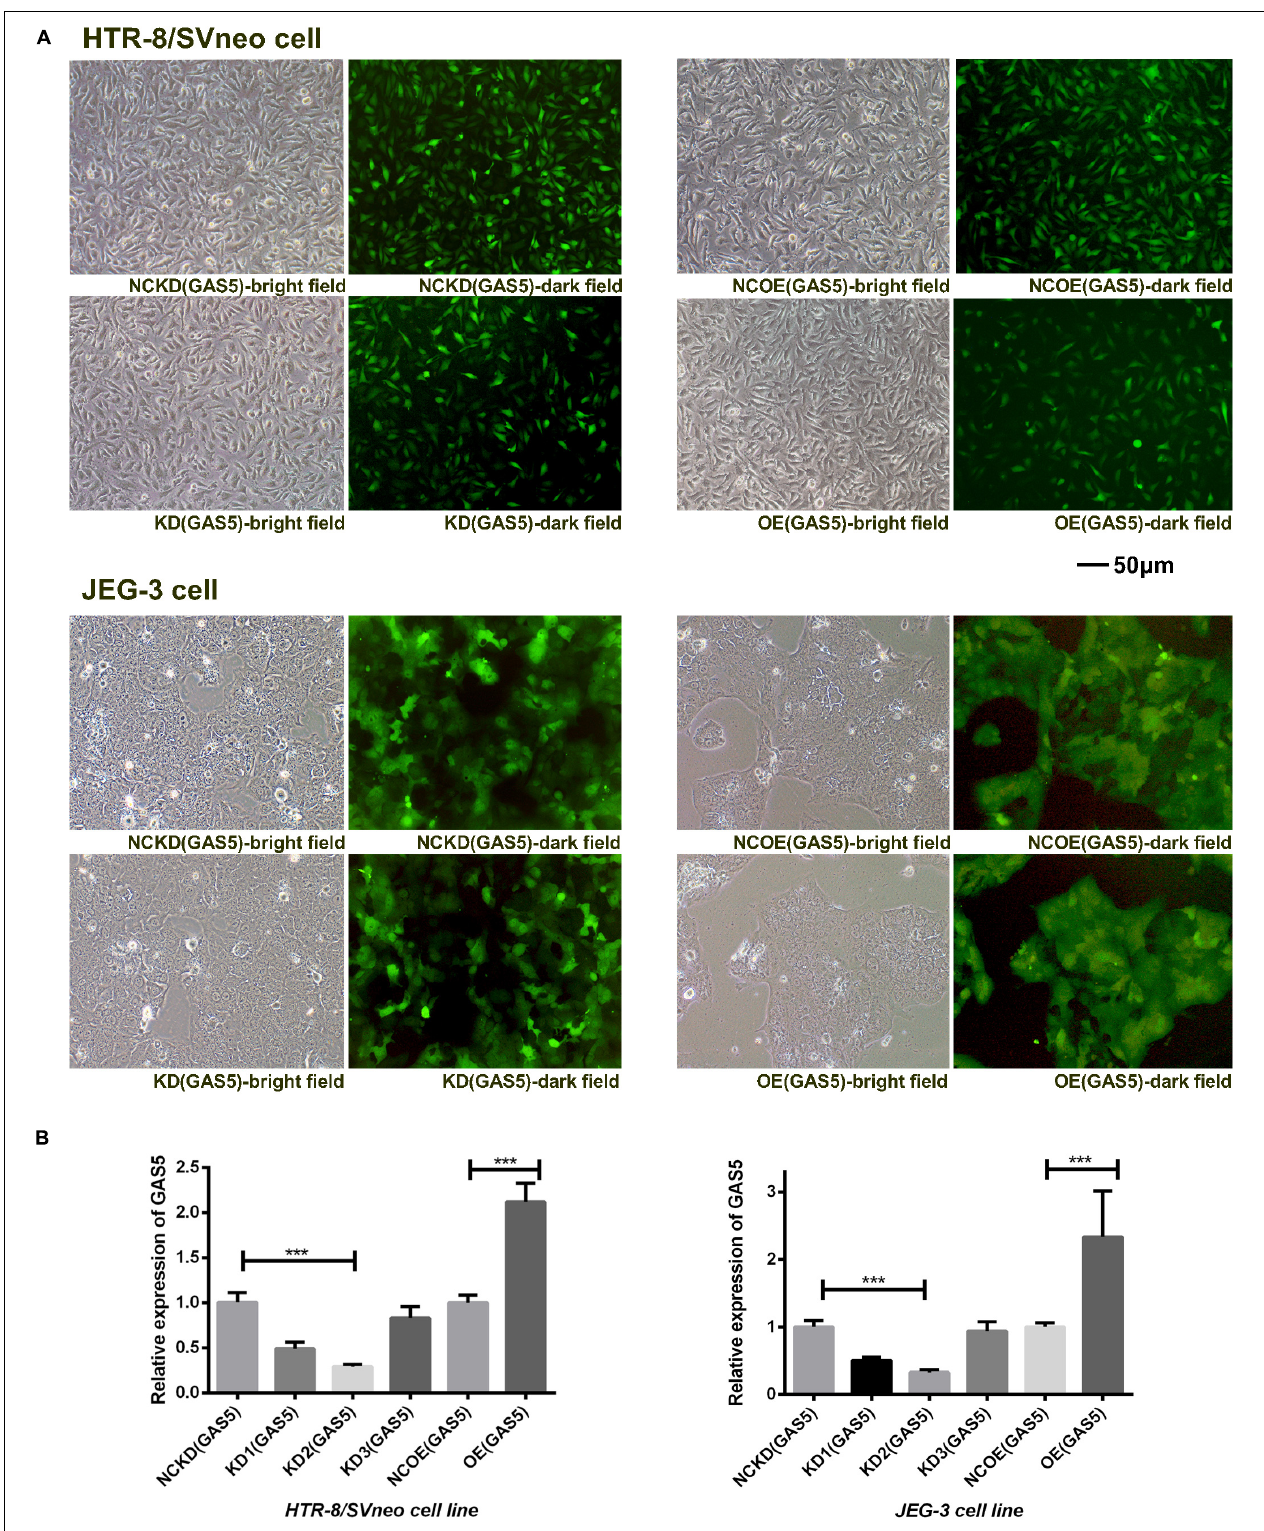
FIGURE 2 | (A) The green fluorescence in the dark field indicated the transfection efficiency of the two trophoblast cell lines. (B) The expression levels of GAS5 altered by lentiviral vectors in two cell lines. KD 2 (GAS5) was selected for subsequent experiments as KD (GAS5) with the highest transfection efficiency. * P < 0.05, ** P < 0.01, *** P <